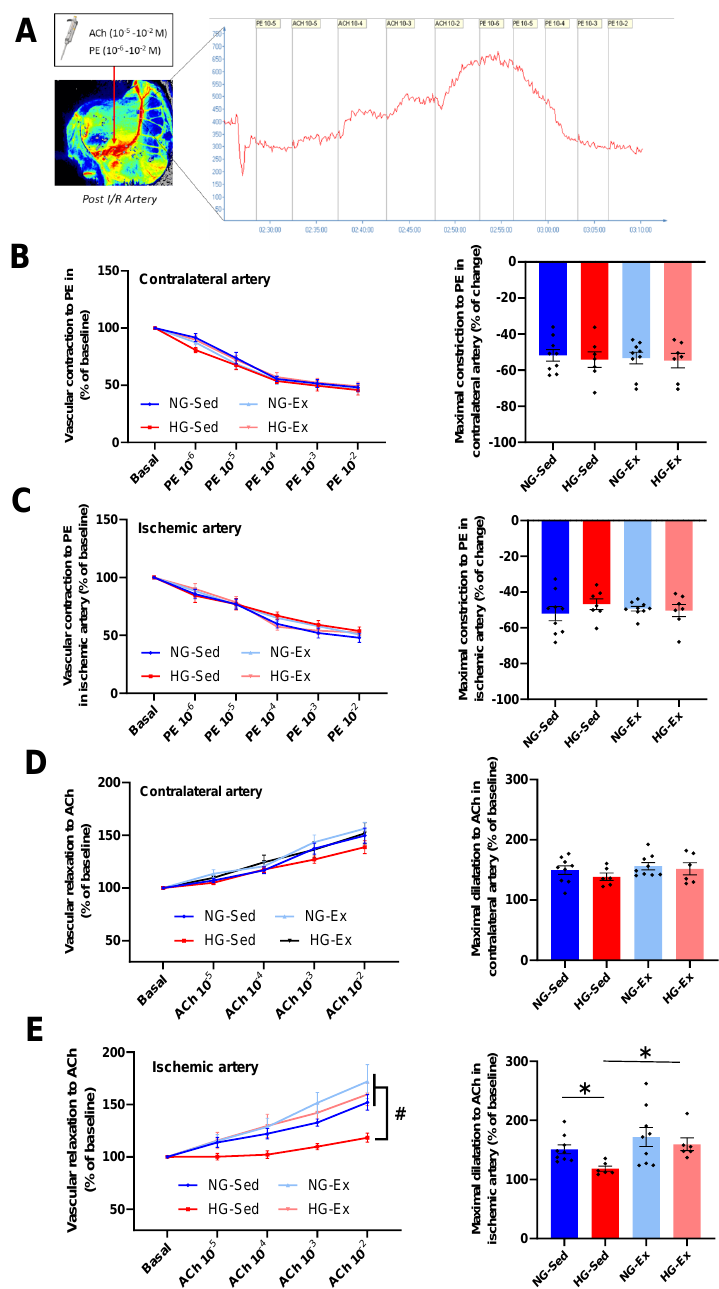
Figure 3. Beneficial impact of chronic exercise training on vascular reactivity in hyperglycemic conditions. ( A ) In vivo protocol of dose–response to acetylcholine (ACh, 10 − 5 to 10 − 2 M) and phenylephrine (PE 10 − 6 to 10 − 2 ) used to evaluate endothelial and smooth muscle function. Perfusion was evaluated using laser speckle contrast imaging. Vascular constriction to phenylephrine on the ( B ) control artery (contralateral limb) and ( C ) ischemic artery. Left panels represent the dose response to phenylephrine (10 − 6 to 10 − 2 M), and right panels represent the maximal constriction to phenylephrine. Vascular relaxation in response to acetylcholine in the ( D ) control artery (contralateral limb) and ( E ) ischemic artery. Left panels represent the dose response to acetylcholine (10 − 5 to 10 − 2 M), and right panels represent maximal relaxation to acetylcholine. n = 7–8 rats per group. ACh: acetylcholine; PE: phenylephrine; NG: normoglycemic; Sed: sedentary; HG: hyperglycemic; Ex: exercise training. *: p < 0.05; #: significantly different from HG-Sed ( p < 0.05). All values are expressed as the mean ± SEM. Comparisons of multiple experimental conditions were performed using analysis of variance (ANOVA) or repeated measures ANOVA followed by Tukey’s post hoc